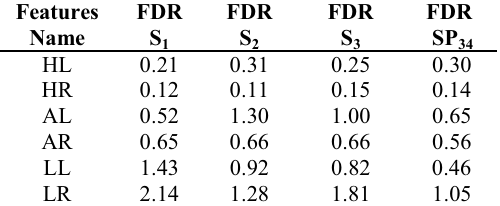
Table 3. Descriptive statistics of features for convex hull